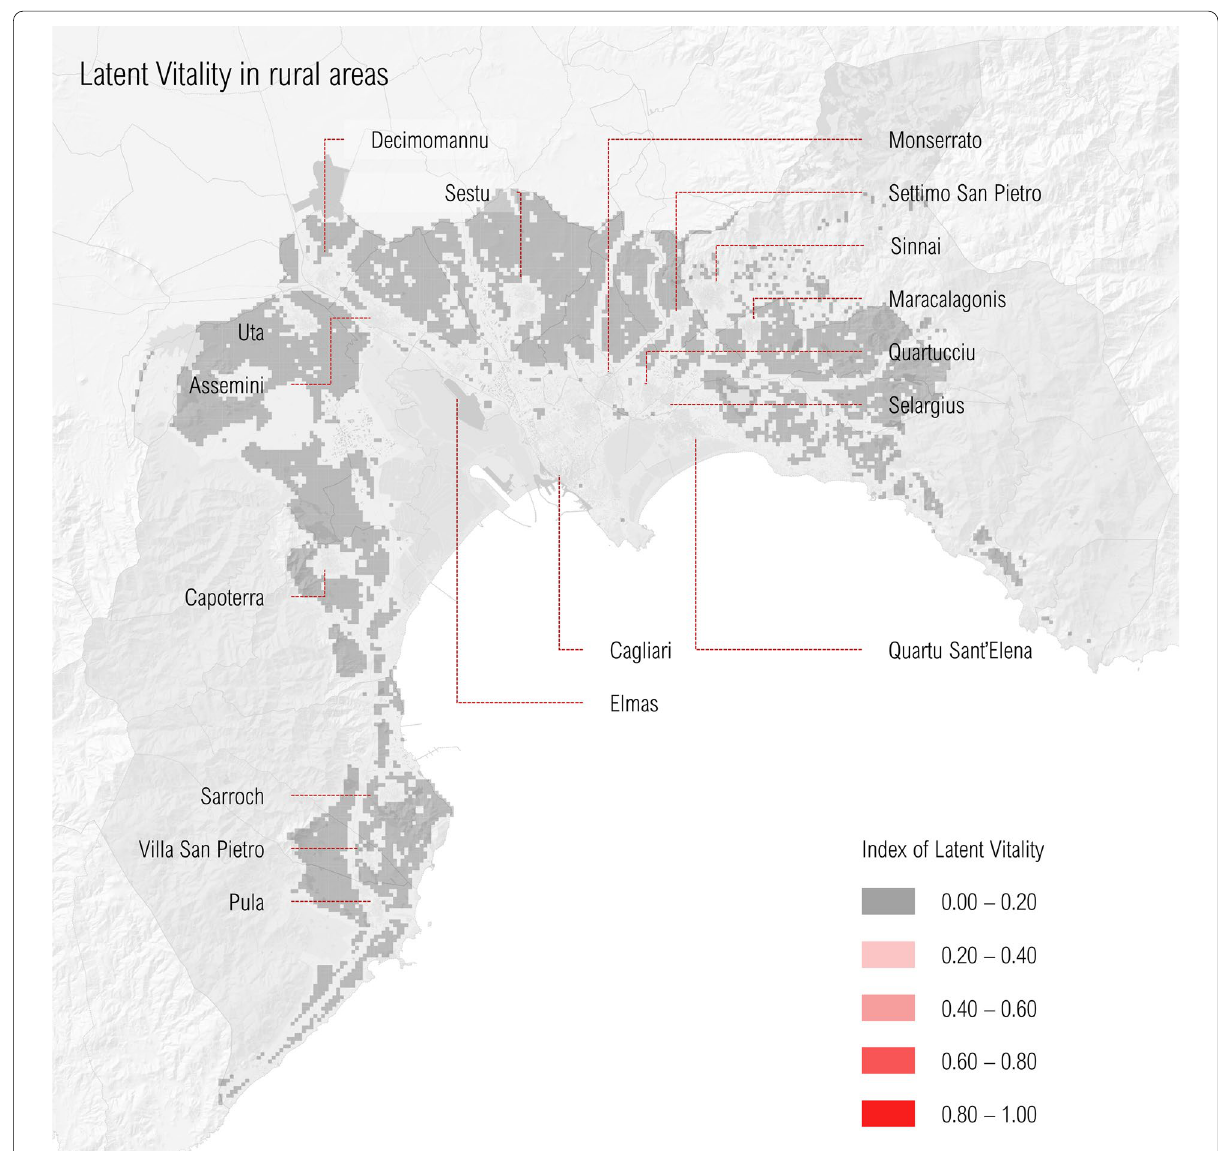
Fig. 7 Distribution of the values of the Synthetic Index of Latent Vitality (I_VIBE) across the fragments of the rural landscapes in the Metropolitan City of